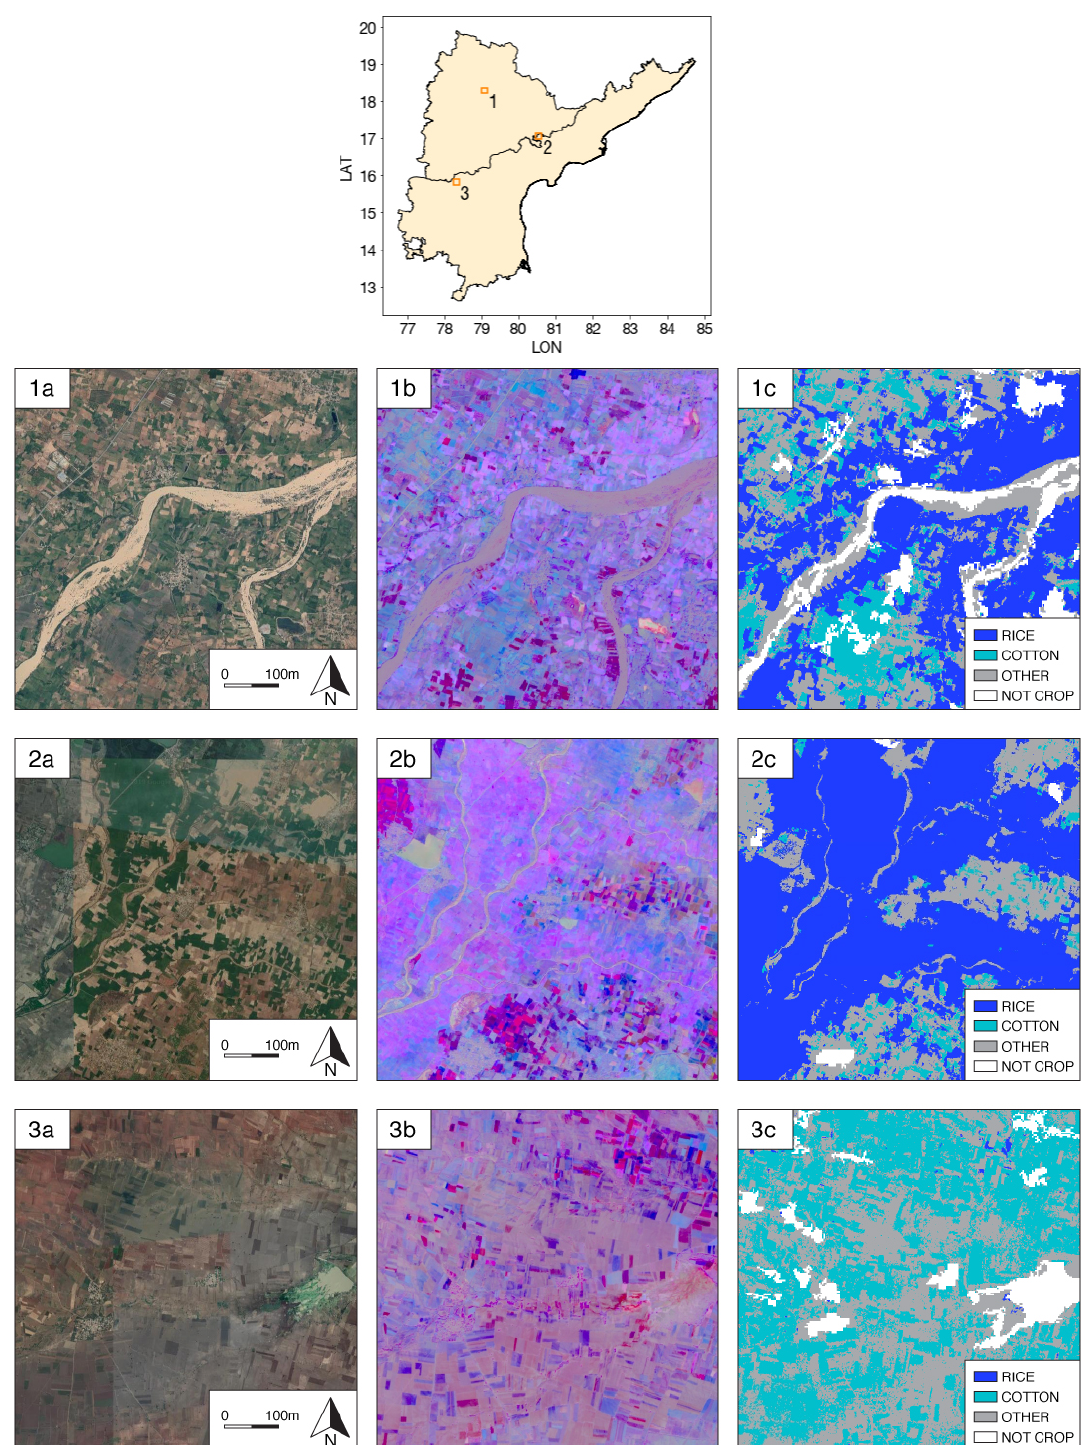
Figure 11. Zooms of predicted crop type map. Classification results on the three-crop task (rice, cotton, and other crop) are shown for three square regions sampled from the study area. From left to right, each row shows ( a ) Google Maps satellite image, ( b ) false color of harmonic coefficients ( GCVI_cos1 , GCVI_sin1 , and GCVI_cos2 ) translated to hue-saturation-value (HSV) color space, and ( c ) crop type classification results using the harmonic features and random forest performed in Google Earth Engine. While numerous prior works have mapped paddy rice in South Asia, Plantix labels and Sentinel data enabled us to create a map that is higher resolution than most existing large-scale